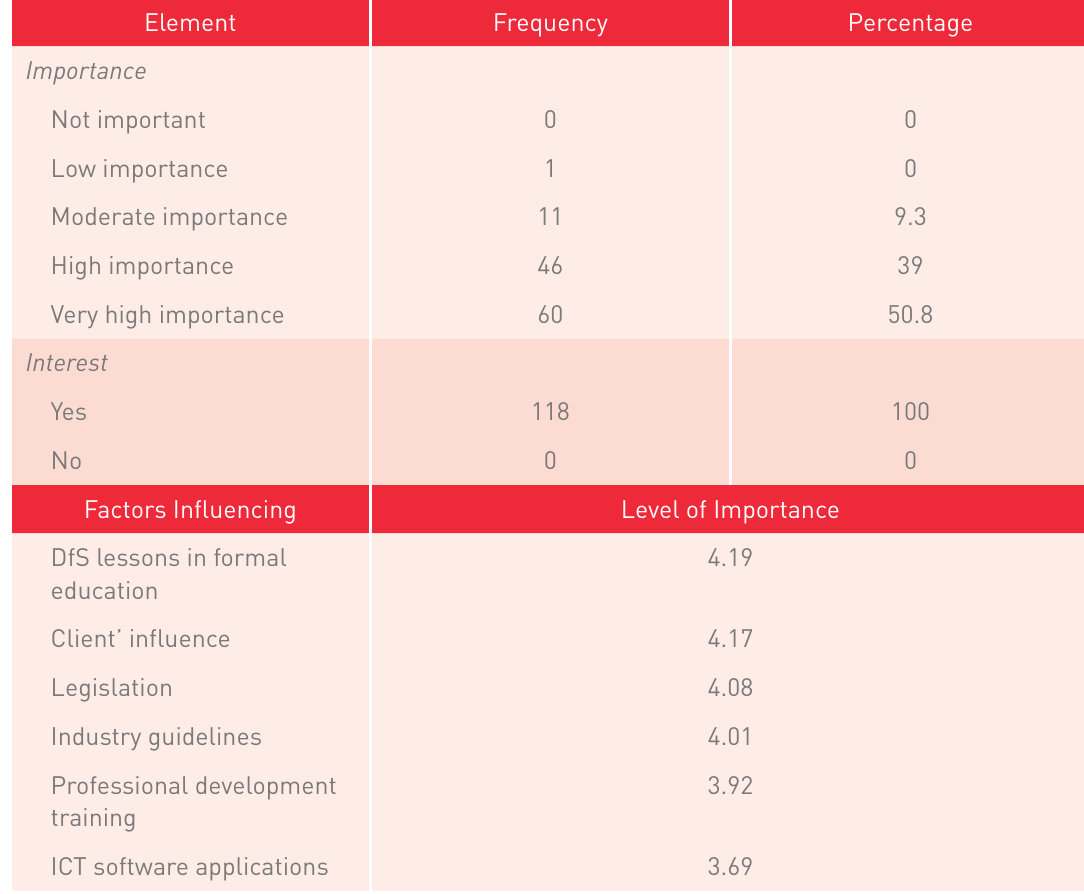
The importance, interest and factors influencing the DfS